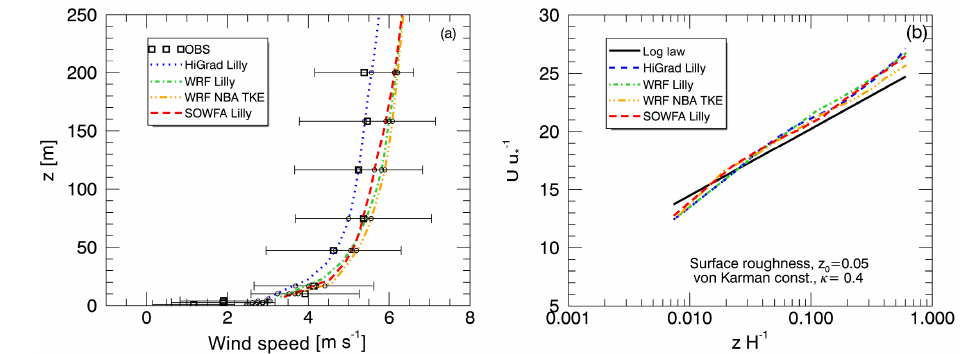
Figure 6. Impacts of different solvers, all using isotropic grids of 15m in each direction, on simulated profiles of time-averaged wind speed plotted against observations (a) and the theoretical logarithmic profile shape (b) , from the neutral case study.